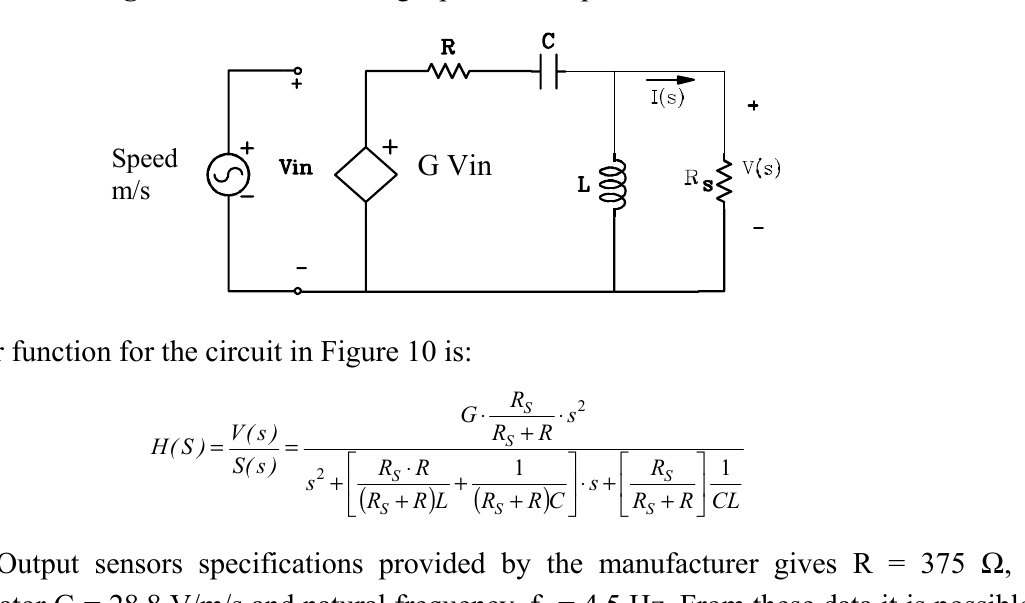
Figure 10. Model of the geophone with passive